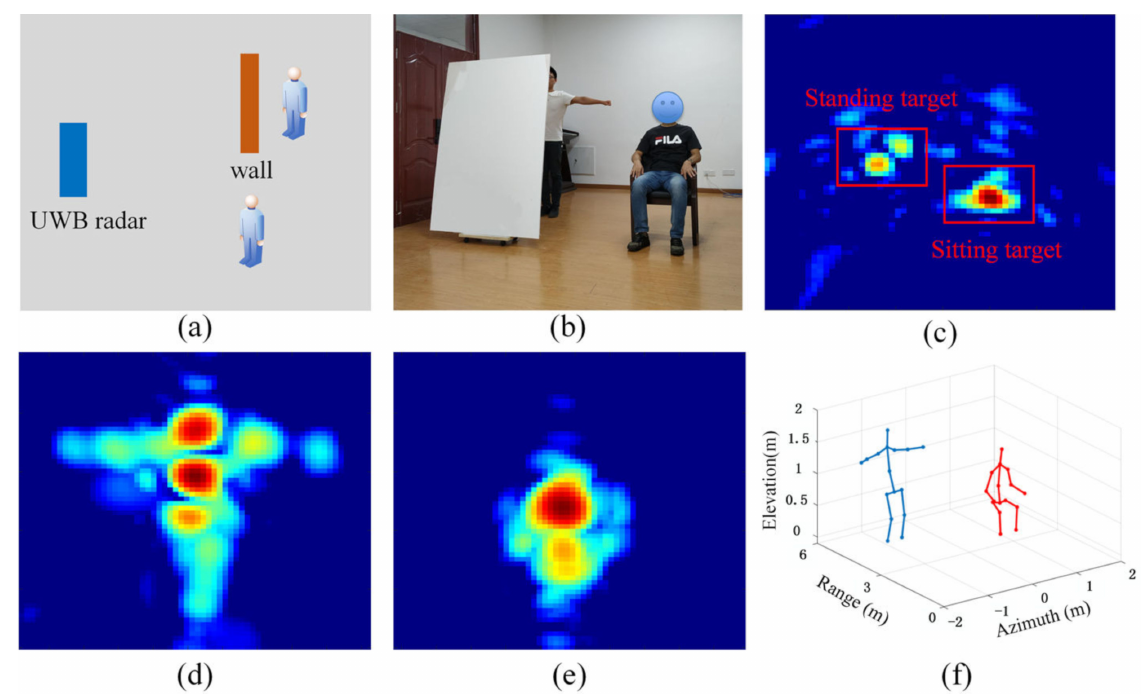
Figure 15. ( a ) Sketch map of the two targets scene; ( b ) Detection scene for visual reference; ( c ) 2D BP imaging result of the whole detection scene; ( d ) Azimuth-height projection image of the 3D BP imaging result of the standing target; ( e ) Azimuth-height projection image of the 3D BP imaging result of the sitting target; ( f ) Pose reconstruction results from our